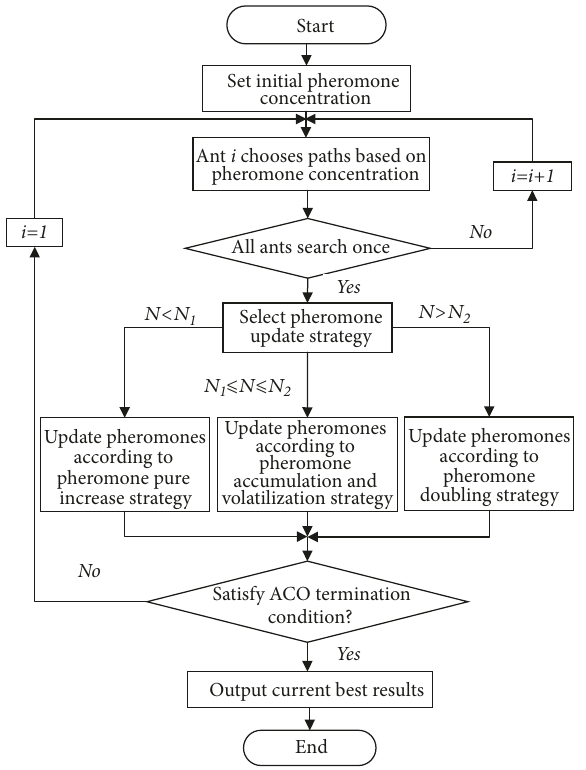
Figure 1: Flowchart of IACO algorithm.